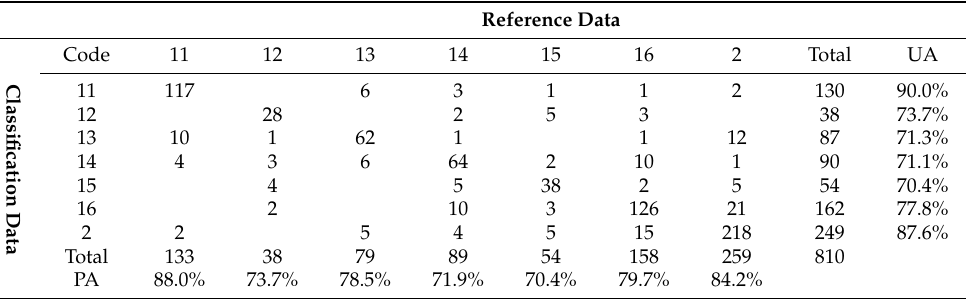
Table 3. Confusion matrix measuring the accuracy of the annual wetland classification result based on traditional supervised classification. Note: The land cover types corresponding to the codes are shown in Table